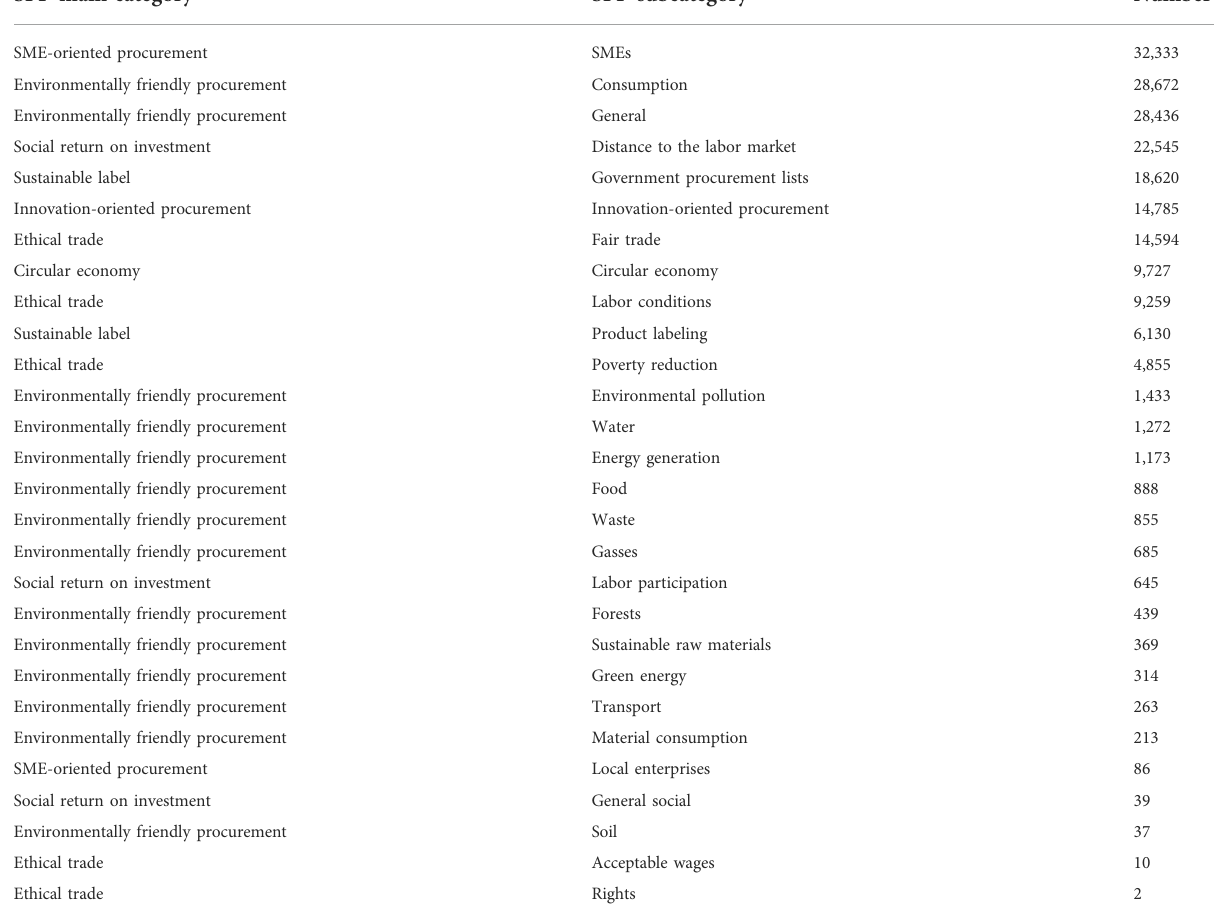
TABLE 4 SPP main- and subcategory implementation ( n =